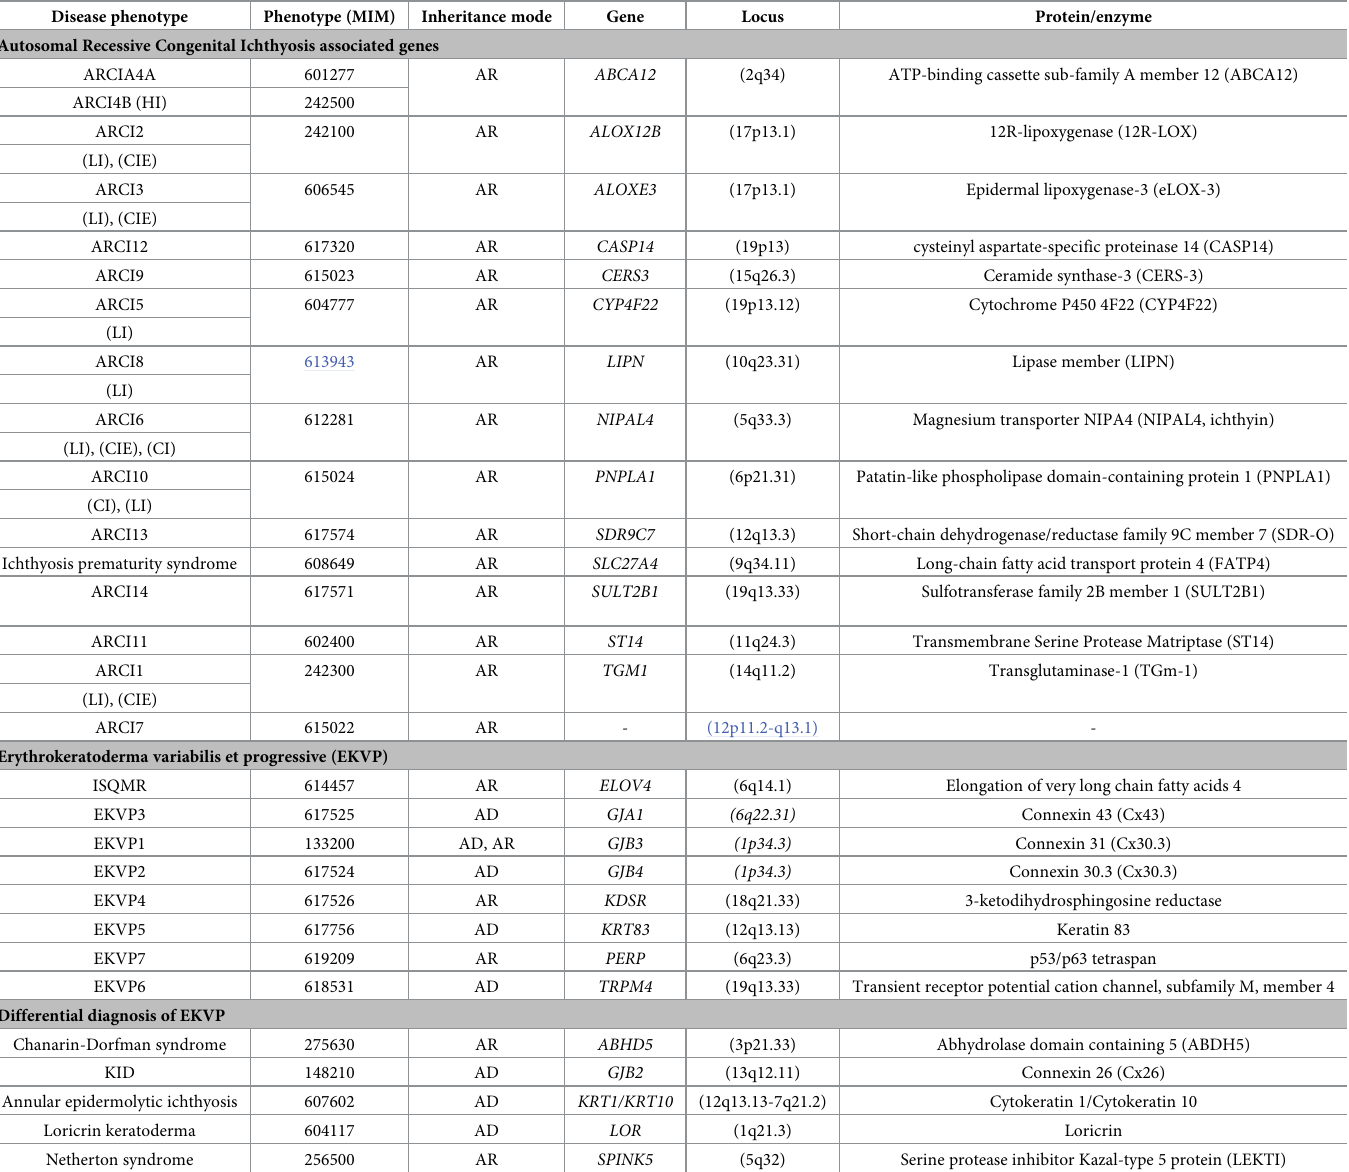
Table 1. List of potential disease causative genes of EKV phenotype of the proband (EKV-ICH1.2). Disease